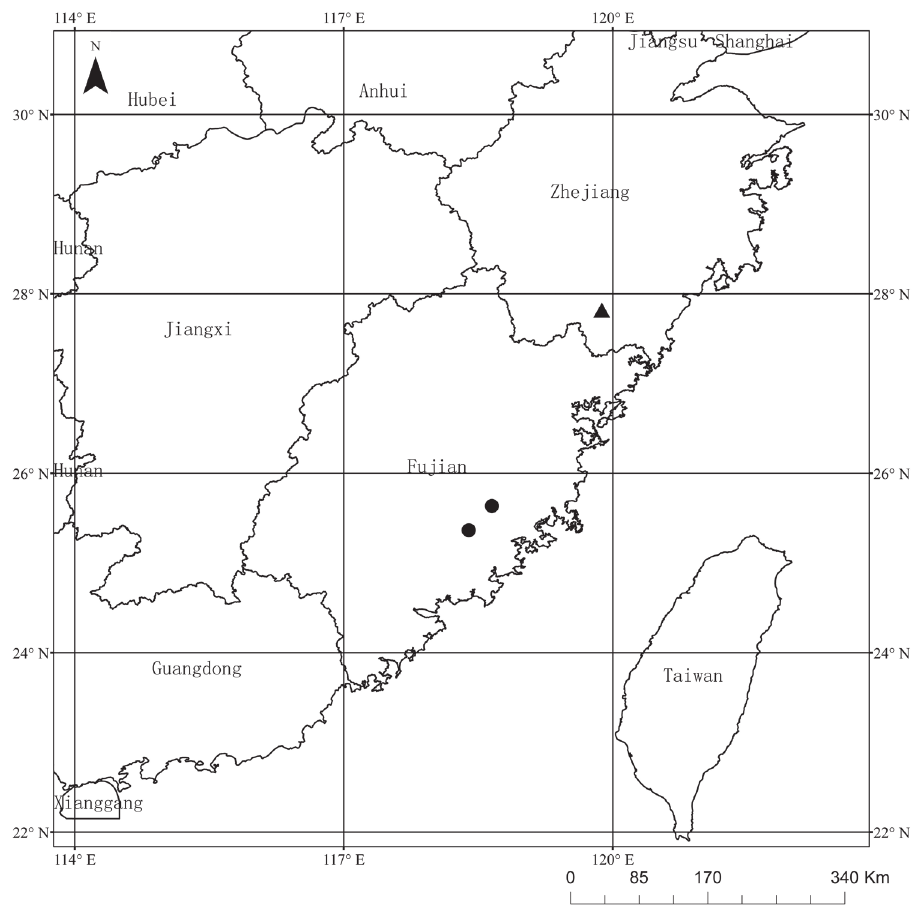
Figure 1. Distribution of Aster quanzhouensis (black circle) and A. tonglingensis (black Description. Perennial herb, 21–30 (60) cm high. Rhizomes thin, with adventi- tious roots, stolons absent. Stem solitary, erect, unbranched except for inflorescence, glabrous or puberulent in upper part. Leaves slightly leathery, narrowly lanceolate, apex acute, base gradually narrowing, subclasping, abaxially light green, adaxially dark green and glossy, 3-veined, midvein abaxially prominent; rosulate leaves 4–13 × 0.4– 1.7 cm, margin serrate, petiole 3–11 cm long, both surfaces glabrous; lower cauline leaves persistent at anthesis or rarely withered, 3–10 × 0.3–0.8 cm, sessile or with ob- scure petioles, margin entire or serrate, abaxially glabrous, adaxially sparsely strigose; middle cauline leaves sessile or with obscure petiole, 4–7 × 0.3–0.4 cm, margin entire or serrate, abaxially glabrous, adaxially sparsely strigose; upper leaves sessile, margin entire. Capitula 9–20 (40) in a terminal corymbose cyme, peduncle puberulent. Invo- lucre campanulate, 5–8 mm in diameter; phyllaries in 5–7 rows, imbricate, lanceolate,